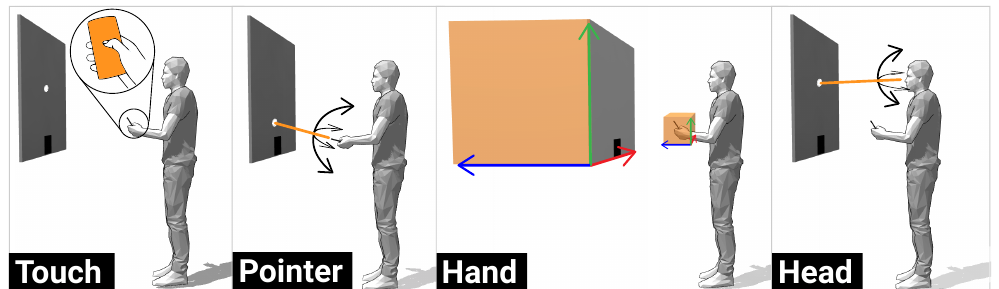
Figure 3. Study interaction techniques: touch, pointer, hand and